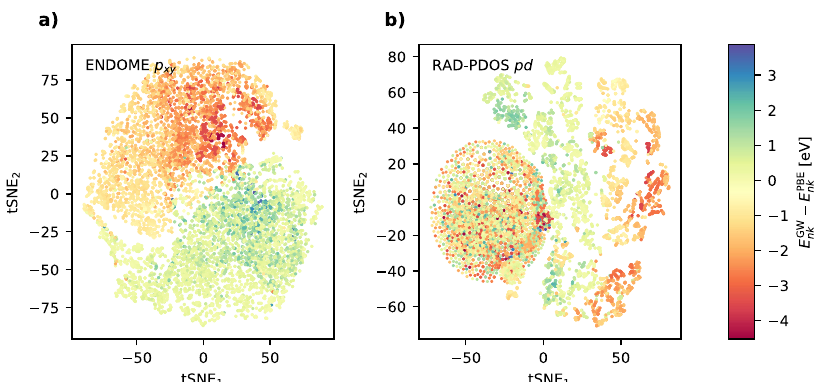
Fig. 3 tSNE visualizations of fi ngerprints. a tSNE components of ENDOME p xy . b tSNE components of RAD-PDOS pd fi ngerprints color-coded with the GW corrections. For p xy , states with similar GW corrections are also close in fi ngerprint space. In b a large amount of the states with both positive and negative GW corrections have similar distances in fi ngerprint space, corresponding to the materials without d -electrons where the RAD-PDOS pd fi ngerprint will be all